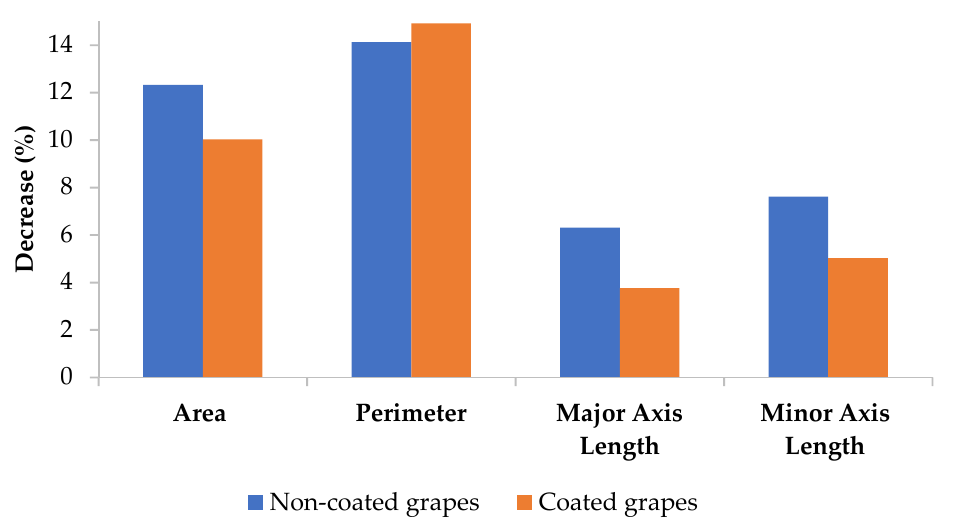
Figure 2. Changes produced in the size of grapes at different storage times. Table 1. Roughness parameters for non-coated and coated grapes without eliminating the shape effect. NON-COATED GRAPES (FINE STRUCTURE +